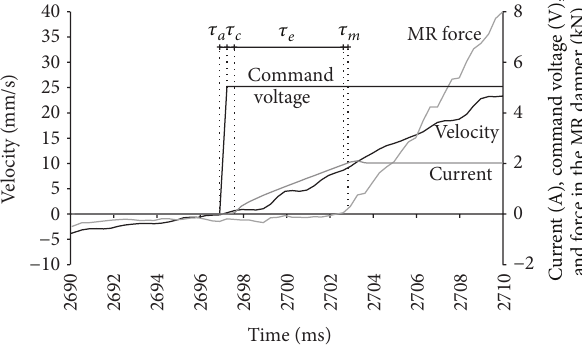
Figure 7: Evaluation of the response time of the case study SA control system under an off → on